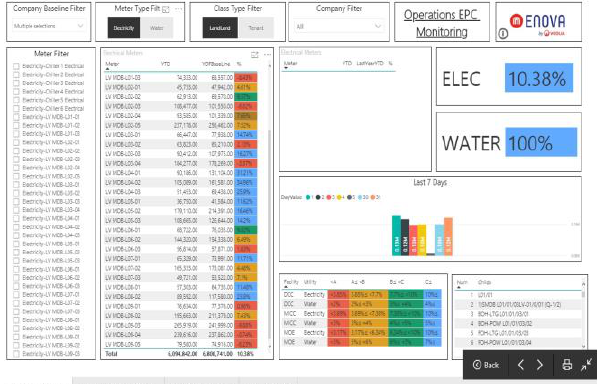
Figure 3: Dashboard showing Metering system readings in one of the shopping centres.